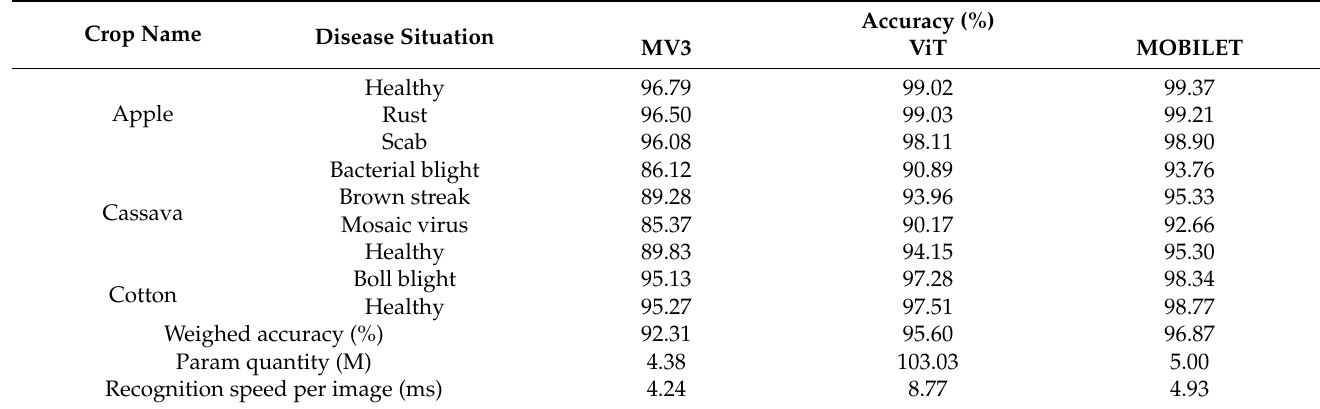
Table 5. Performance of different models on various disease images. MV3 is the abbreviation of MobileNet-V3, ViT is a pure Transformer model, MOBILET is the improved model proposed in this paper.